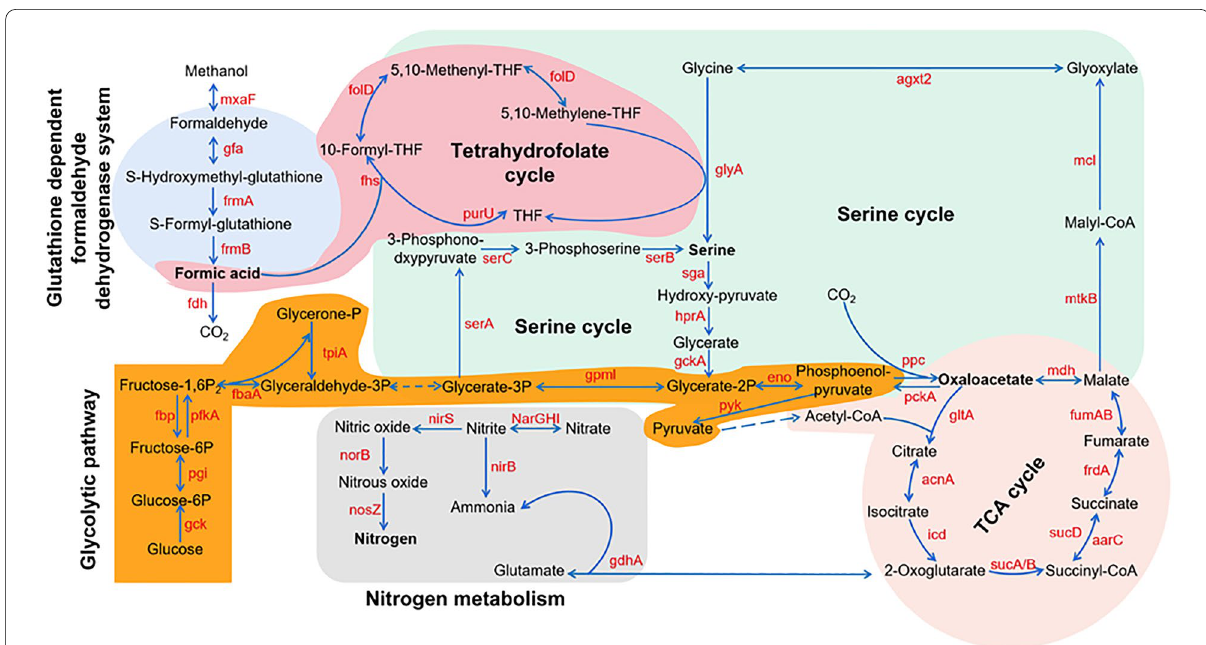
Fig. 2 Proposed central metabolism pathways of strain MA5. maxF methanol dehydrogenase, gfa S-(hydroxymethyl)glutathione synthase, frmA S-(hydroxymethyl)glutathione dehydrogenase, frmB S-formylglutathione hydrolase, fdh formate dehydrogenase, fhs formate-tetrahydrofolate ligase, purU formyltetrahydrofolate deformylase, folD methylene-tetrahydrofolate dehydrogenase/methenyltetrahydrofolate cyclohydrolase, glyA glycine hydroxymethyltransferase, sga serine glyoxylate transaminase, hprA glycerate dehydrogenase, gckA glycerate 2-kinase, gpmI 2,3-bisphosphoglycera te-independent phosphoglycerate mutase, serA D-3-phosphoglycerate dehydrogenase, serC phosphoserine aminotransferase’, serB phosphoserine phosphatase, eno enolase, ppc phosphoenolpyruvate carboxylase, pckA phosphoenolpyruvate carboxykinase, mdh malate dehydrogenase, mtkB malate-CoA ligase, mcl malyl-CoA/(S)-citramalyl-CoA lyase, agxt2 alanine-glyoxylate transaminase, tpiA triosephosphate isomerase, fbaA fructose-bisphosphate aldolase, pfkA 6-phosphofructokinase, fbp fructose-1,6-bisphosphatase, pgi glucose-6-phosphate isomerase, gck glucokinase, pyk pyruvate kinase, gltA citrate synthase, acnA aconitate hydratase, icd isocitrate dehydrogenase, sucA 2-oxoglutarate dehydrogenase E1 component, sucB 2-oxoglutarate dehydrogenase E2 component, sucD succinyl-CoA synthetase alpha subunit, aarC succinyl-CoA:acetate CoA-transferase, frdA fumarate reductase flavoprotein subunit, fumAB fumarate hydratase, narGHI nitrate reductase, nirBS nitrite reductase, norB nitric oxide reductase, nosZ nitrous oxide reductase, gdhA glutamate dehydrogenase. Dotted arrows indicate multistep